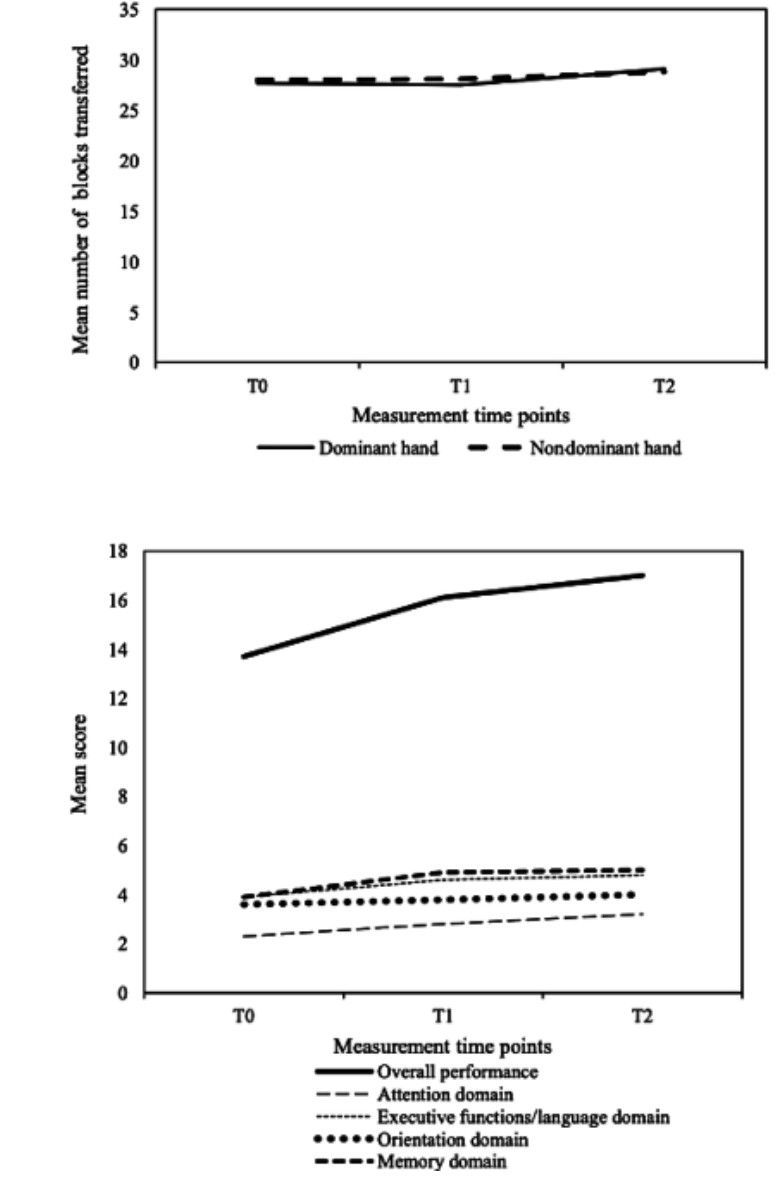
Figure 2. Change in health outcomes over three measurement time points (baseline [T0], 6 weeks after baseline [T1], and 3 months after baseline [T2]). (A) Block and Block Test (BBT), a larger number of blocks transferred indicates better upper-limb dexterity; P values for time difference: .008 (dominant hand) and .043 (nondominant hand). (B) Montreal Cognitive Assessment 5-Minutes (Hong Kong Version) (HK-MoCA 5-Min), a higher score indicates better cognitive status; P values for time difference: <.001 (overall performance), <.001 (attention domain), <.001 (executive functions/language domain), .004 (orientation domain), and <.001 (memory